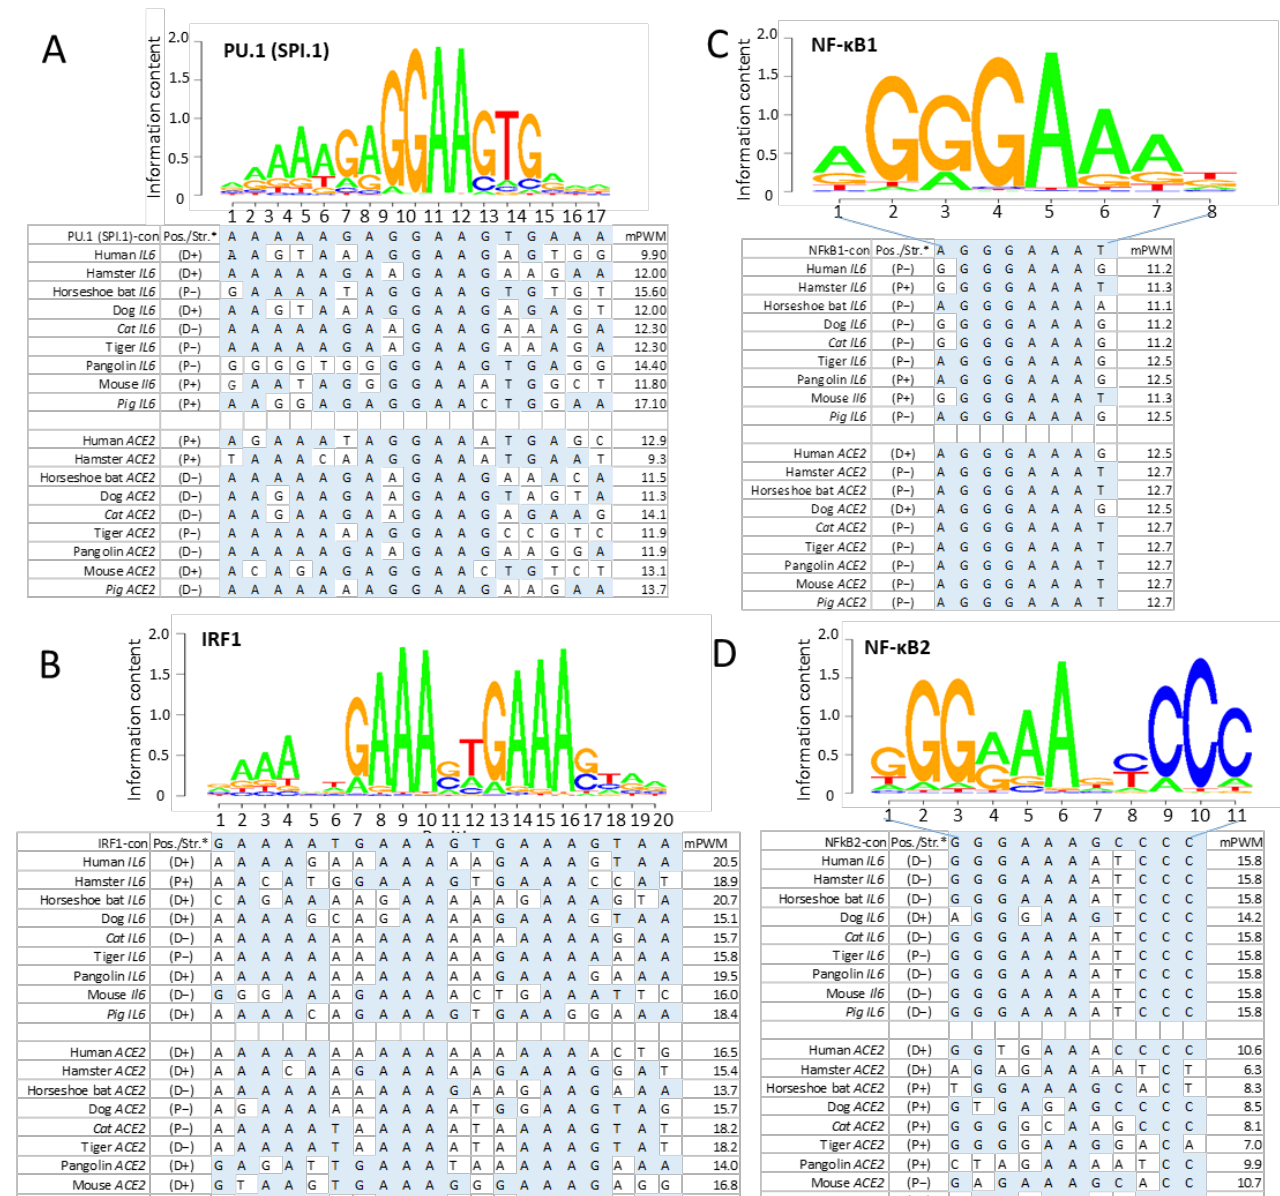
Figure 3. Existence of cis -regulatory elements (CREs) that bind typical non-ISGs transcription factors of ( A ) PU.1 (a.k.a. SPI1), ( B ) IRF1, and ( C , D ) NF- κ B1/2 in the promoter regions of IL-6 and ACE2 gene orthologs from the representative two SARS-CoV-2-unsusceptible species (pigs and mice) and seven susceptible species. All three types of CREs have comparable Log 2 (mPWM) scores between ACE2 and IL-6 genes, except NF- κ B2 that mediates non-canonical NF- κ B response. ( D ) has a significant lower mPWN score (2–6 Log 2 units), indicating ACE2 genes are among different non-ISGs group other than IL-6. P/D, proximal or distal regions of promoters; ± sense or antisense strands. mPWM scores were calculated using tools at https://ccg.epfl.ch/pwmtools/pwmscore.php with CRE Matrices are from MEME-derived HOCOMOCOv11 TF collection affiliated with the PWM tools. PWM, position weight matrix.